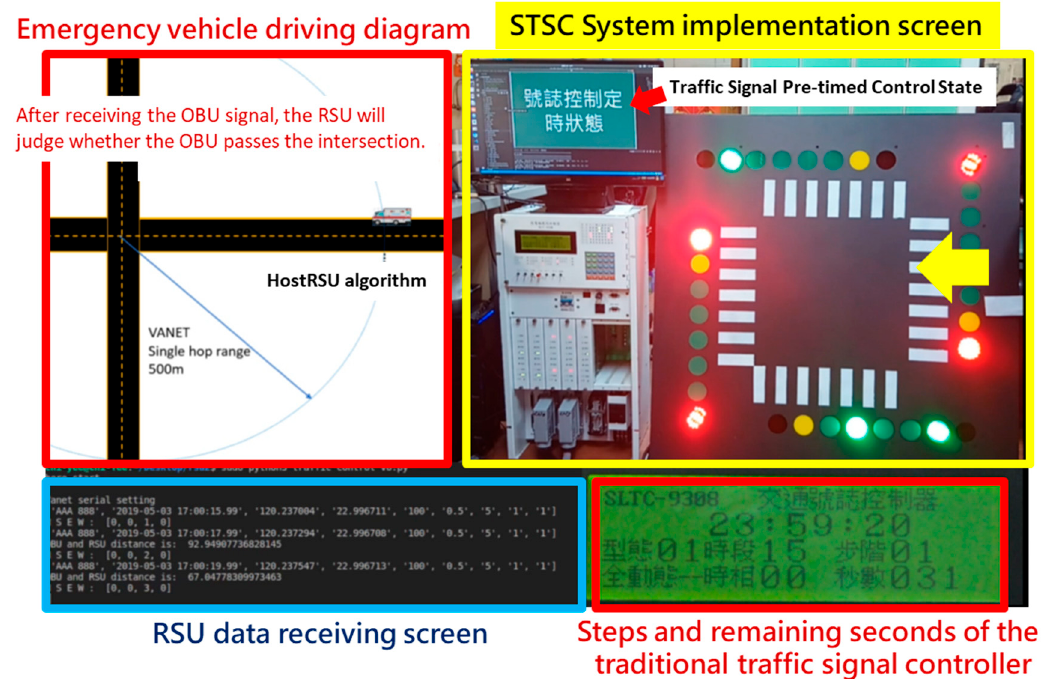
Figure 15. Testing EVSP functions in the lab.